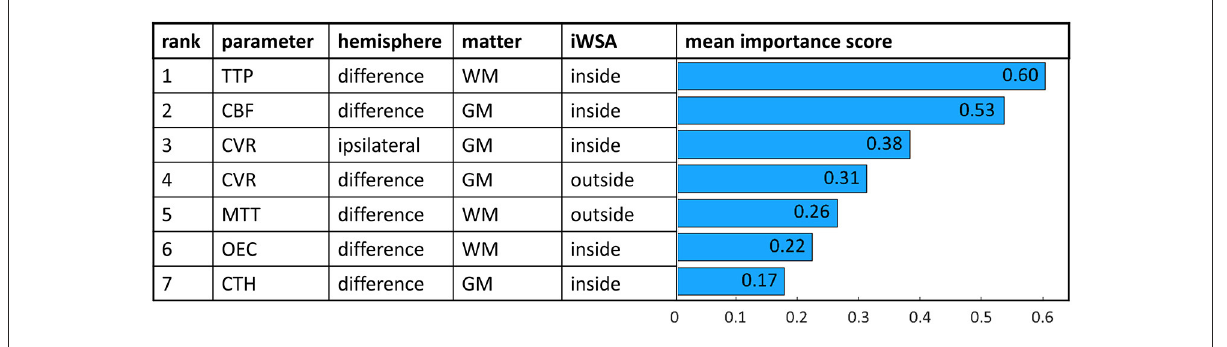
FIGURE3 Feature importance scores of a random forest classifier trained with 7 highest ranked features. Scores were averaged 1,000 times. Corresponding parameters, VOI characteristics and mean importance scores are shown for each